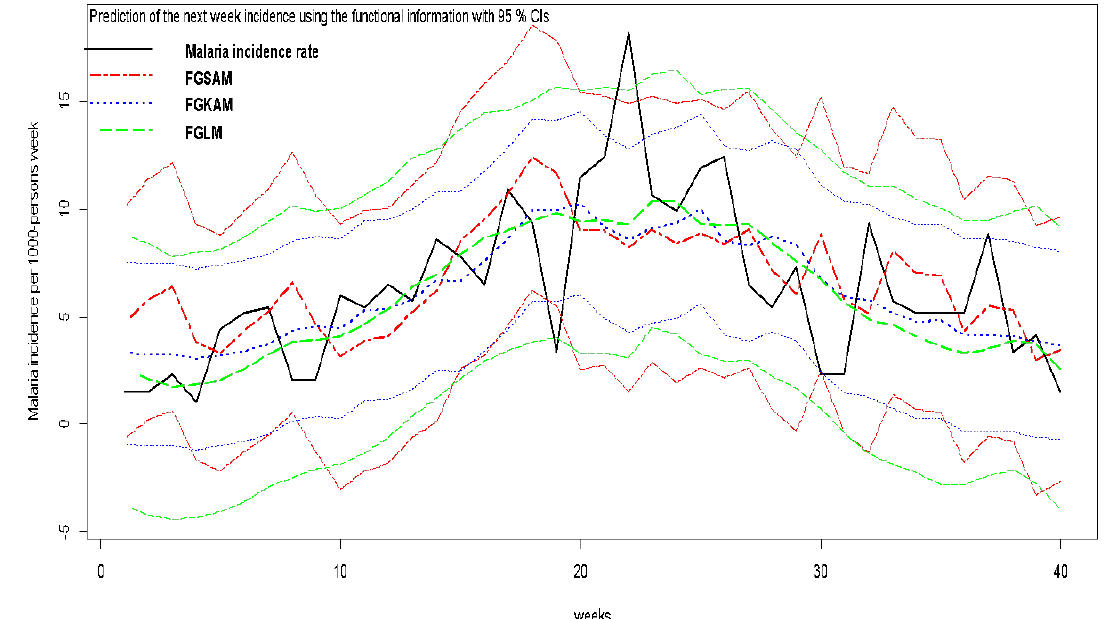
Figure 5. Prediction of the raw rates (cases per 1000 / pop) in the village of Dangassa i . i The predictions have been made in the validation period for the Functional Generalized Spectral Additive Model (FGSAM), the Functional Generalized Linear Model (FGLM), and the Functional Generalized Kernel Additive Model (FGKAM). We used functional information based on past incidence and meteorological covariates with 95% Confidence Intervals (CIs). The black solid line represents the validation set (40-week)-based incidence (observed). The two dashed red lines represent the FGSAM predictions and its 95% CI. The dotted blue lines represent the FKAM predictions and its 95% CI. The green long dash lines represent the FGLM predictions and its 95% CI. All 3 models performed well, but FGLM has 95% CI curves closer to the validation set incidence curves. FGLM seems to have the best tuned 95% CI prediction bandwidth.